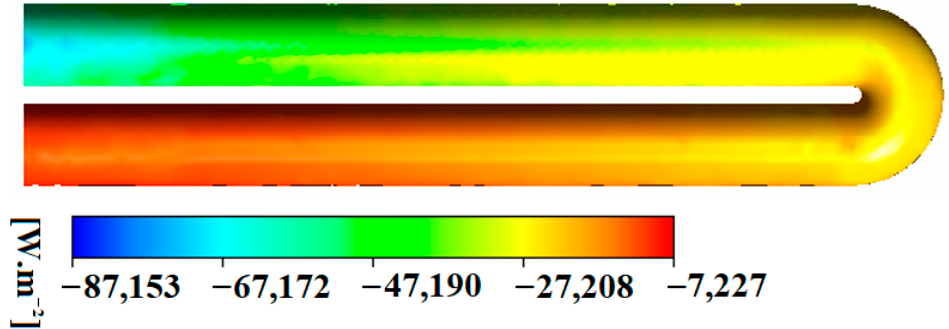
Figure 6. Heat flux distribution across the fire tube wall.